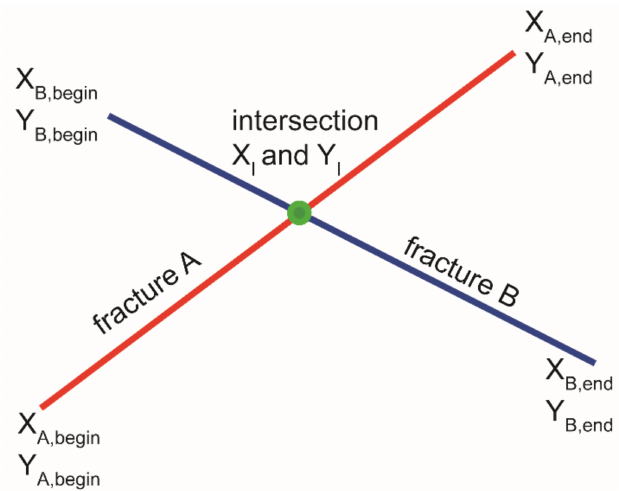
Figure 2. Determination of the intersection of two intersecting